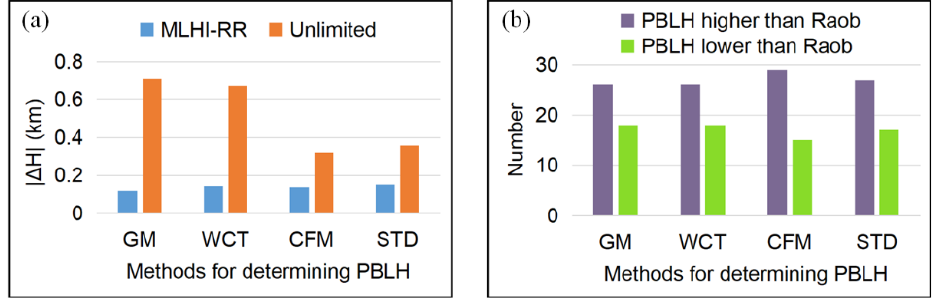
Figure 8. In the multi-layer conditions, comparing ( a ) the divergence of the PBLH derived from radiosonde and four lidar methods with MLHI-RR and without limiter; ( b ) the relative height of PBLH from lidar with MLHI-RR and radiosonde.